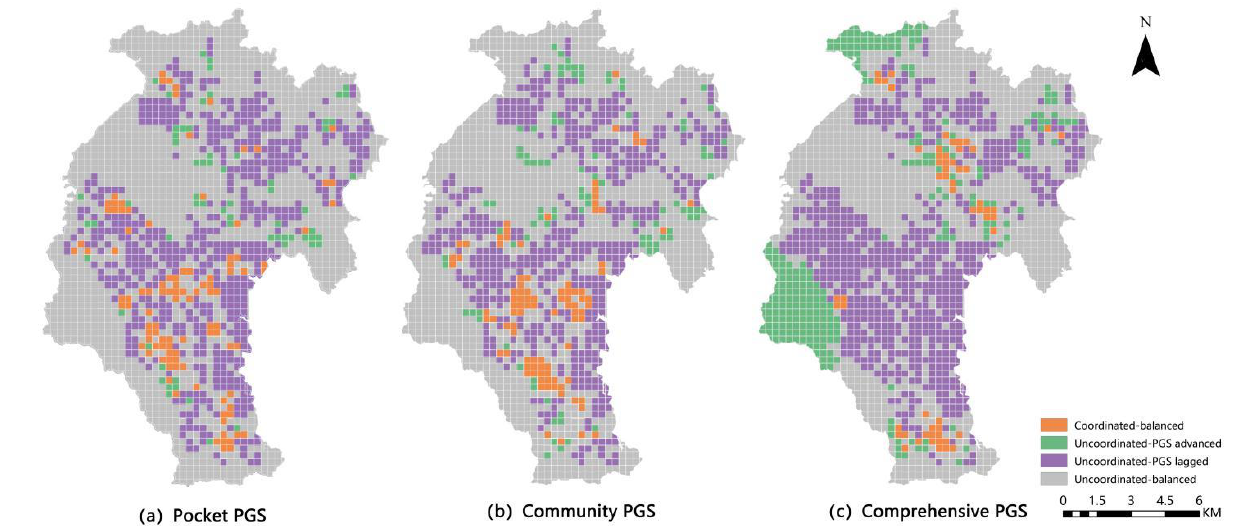
Figure 12. Development strategic zoning for ( a ) pocket PGS, ( b ) Community PGS and ( c ) Compre- hensive PGS.